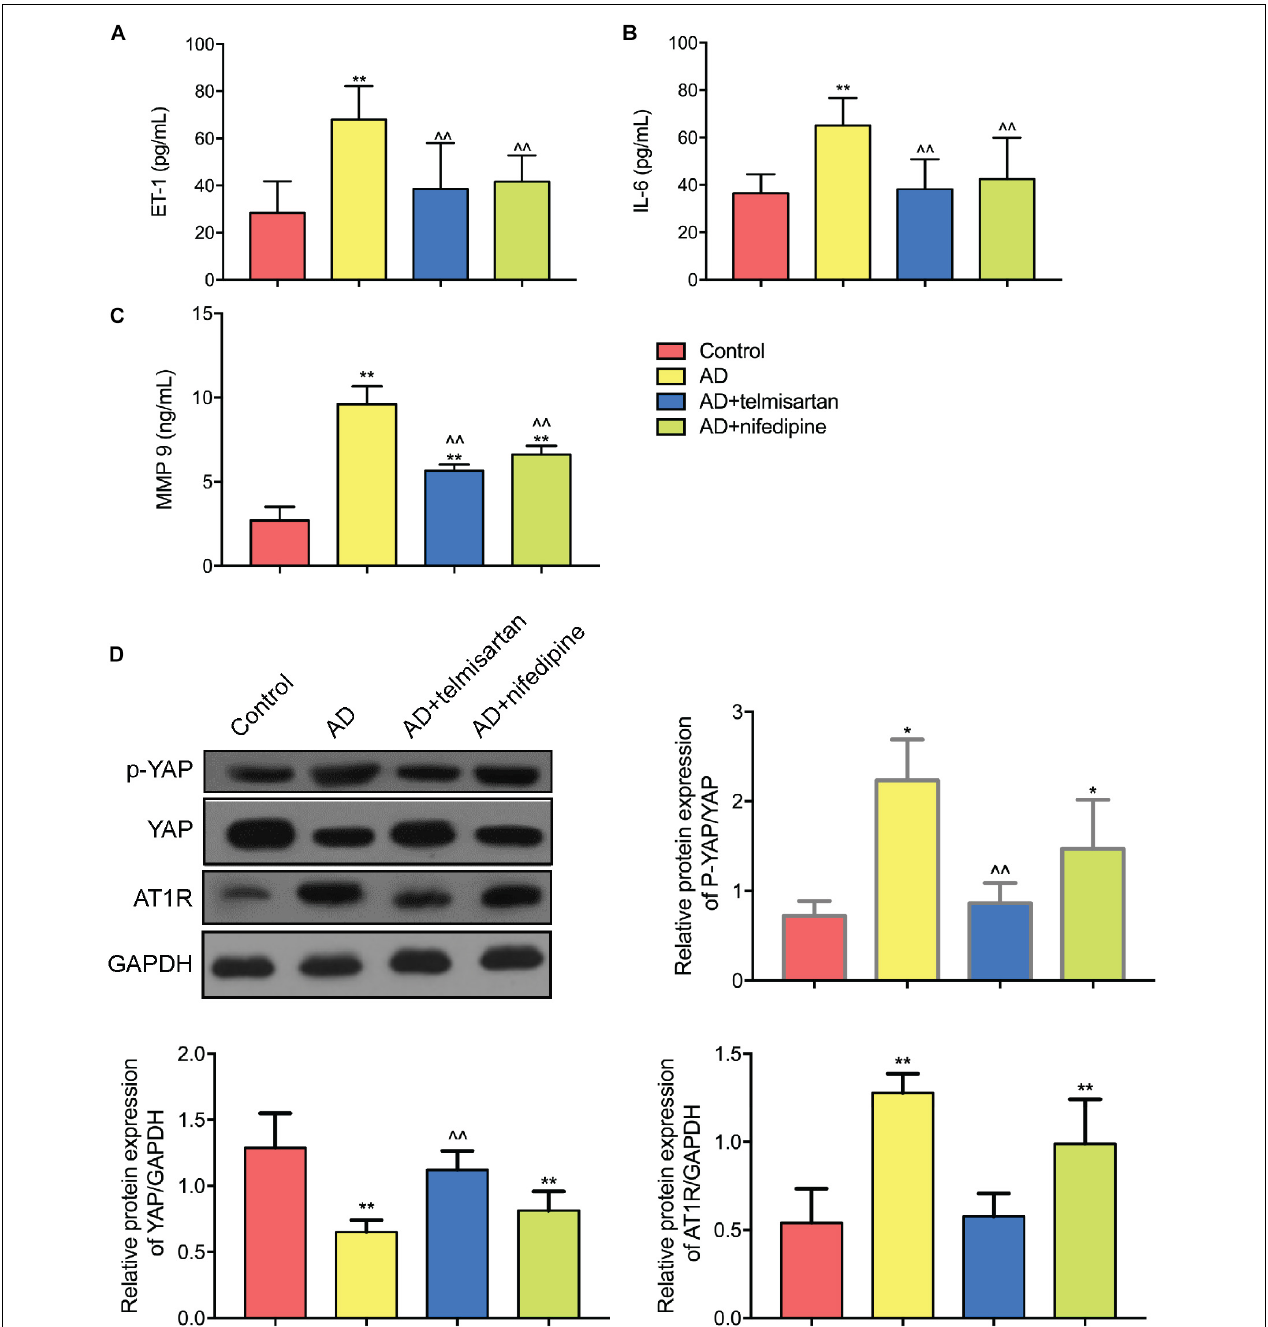
FIGURE 8 | ELISA and Western Blot results of aortic tissue in each group of mice. (A) ET-1 ELISA results were shown. Both telmisartan and nifedipine treatments can effectively reduce ET-1 serum levels in the AD mice model. Telmisartan is slightly better than nifedipine. (B) IL-6 ELISA results were shown. Both telmisartan and nifedipine treatments can effectively reduce IL-6 serum levels in the AD mice model. Telmisartan is slightly better than nifedipine. (C) MMP 9 ELISA results were shown. Both telmisartan and nifedipine treatments can effectively reduce MMP 9 serum levels in the AD mice model. Telmisartan is slightly better than nifedipine. (D) Western Blot results of YAP and AT1R content in aortic tissue of each group were demonstrated. The contents of AT1R and p-YAP in the aortic tissue of AD group were significantly increased, and the total content of YAP was decreased. Telmisartan treatment can effectively alleviate this phenomenon, and nifedipine cannot affect the expression of AT1R and YAP. ( n = 3, mean and S.D., t -test, * P < 0.01 compared with control group; ** P < 0.05 compared with the control group; ∧∧ P < 0.05 compared with the AD group; ## P < 0.05 compared with the AD + telmisartan group).